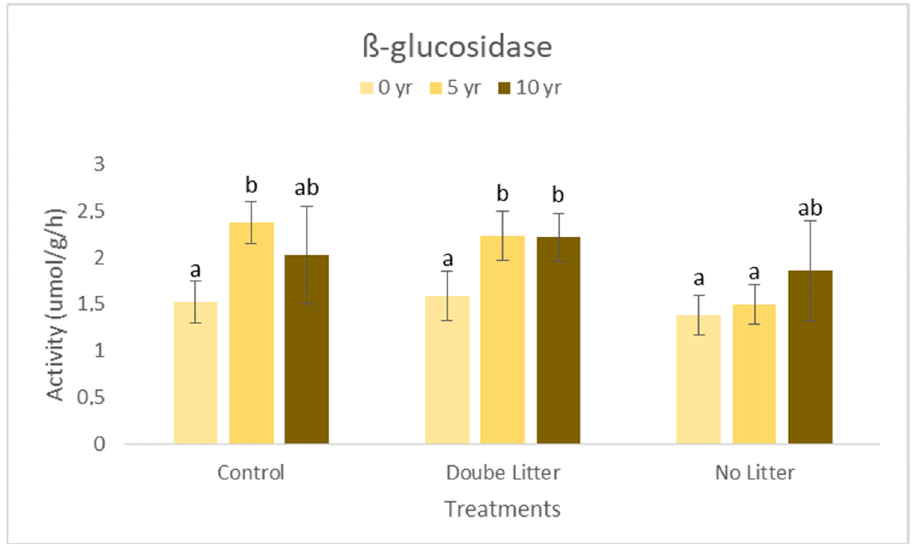
Figure 5. Soil ß-glucosidase enzyme activity at the start of the treatments and after 5 and 10 years, based on spring measurements (average of 6 samples per treatment; letters indicate the significant difference between treatments within the same sampling time.).